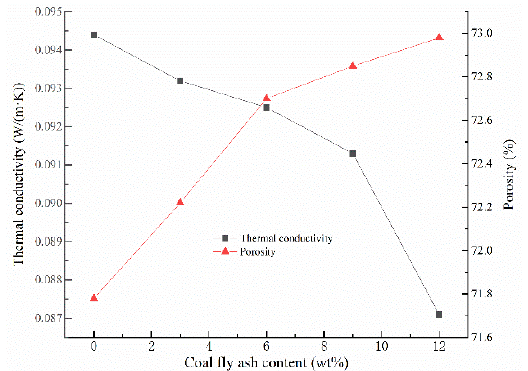
Figure 4. Thermal conductivity and porosity versus the addition of CFA.